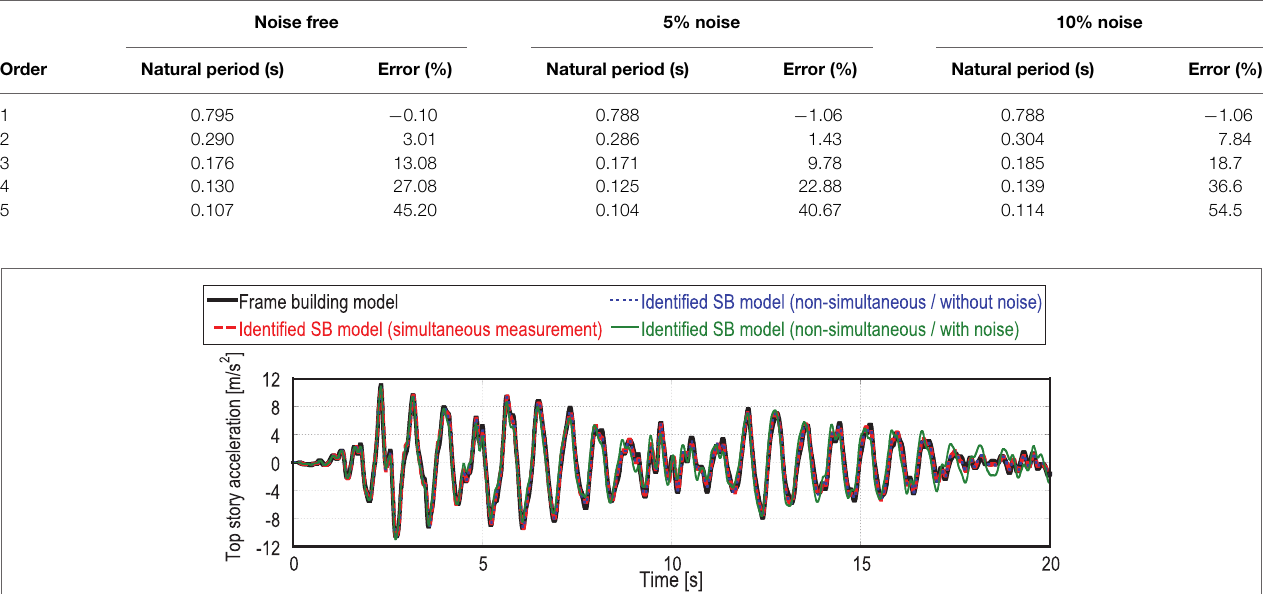
conducted by Fujita et al. (2013) to show the applicability of the previously proposed SI method. The accuracy and reliability of the proposed SI method in the non-simultaneous measurement are investigated by using micro-tremor